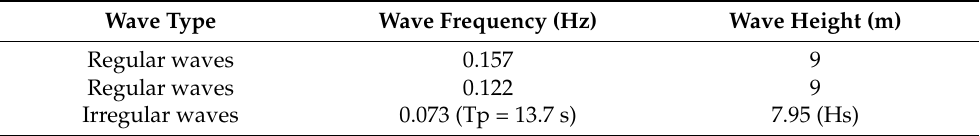
Table 4. Wave parameters for the benchmarking study between the proposed method and ABAQUS.